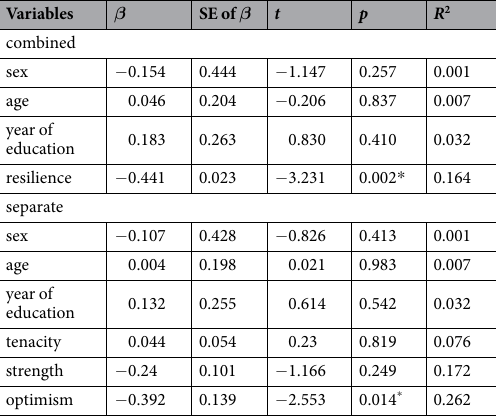
Table 1. Regression results with combined and separate resilience factors. β : regression coefficient; SE: standard error; * statistical